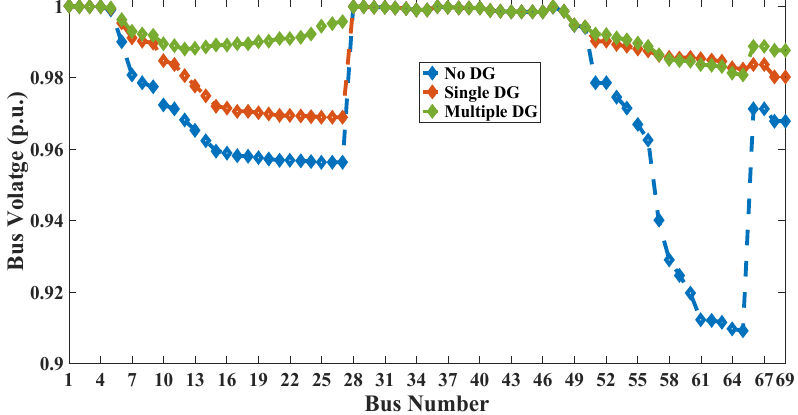
Figure 6. Variation of bus voltage before and after placement of DG for Constant Load.